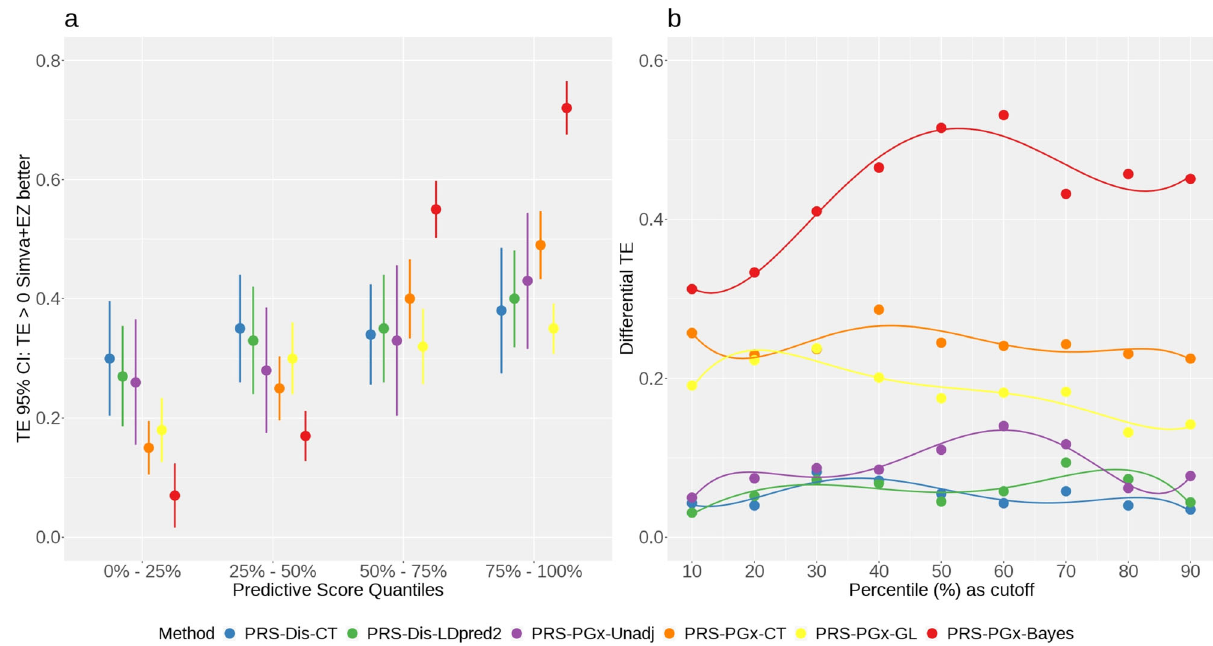
Fig. 4 | Patient strati fi cationperformance ofsix polygenicprediction methods in the IMPROVE-IT PGx real data analysis with n =5661 unrelated European samples. a Quantile plot of treatment effect using four fi xed quantiles (0 – 25%, 25 – 50%,50 – 75%,and75 – 100%).EachdotstandsfortheobservedTreatmentEffect